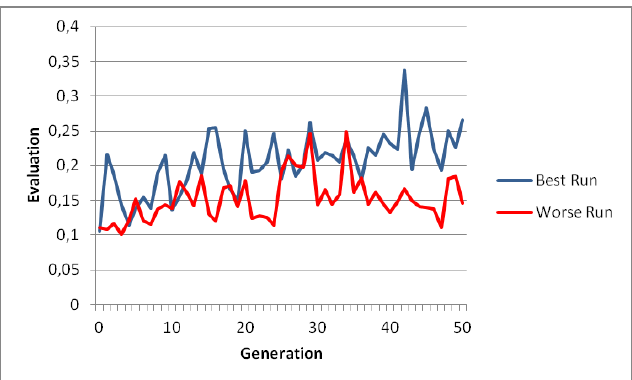
Fig. 7. Average number of individuals who reached the door in each generation considering five runs.